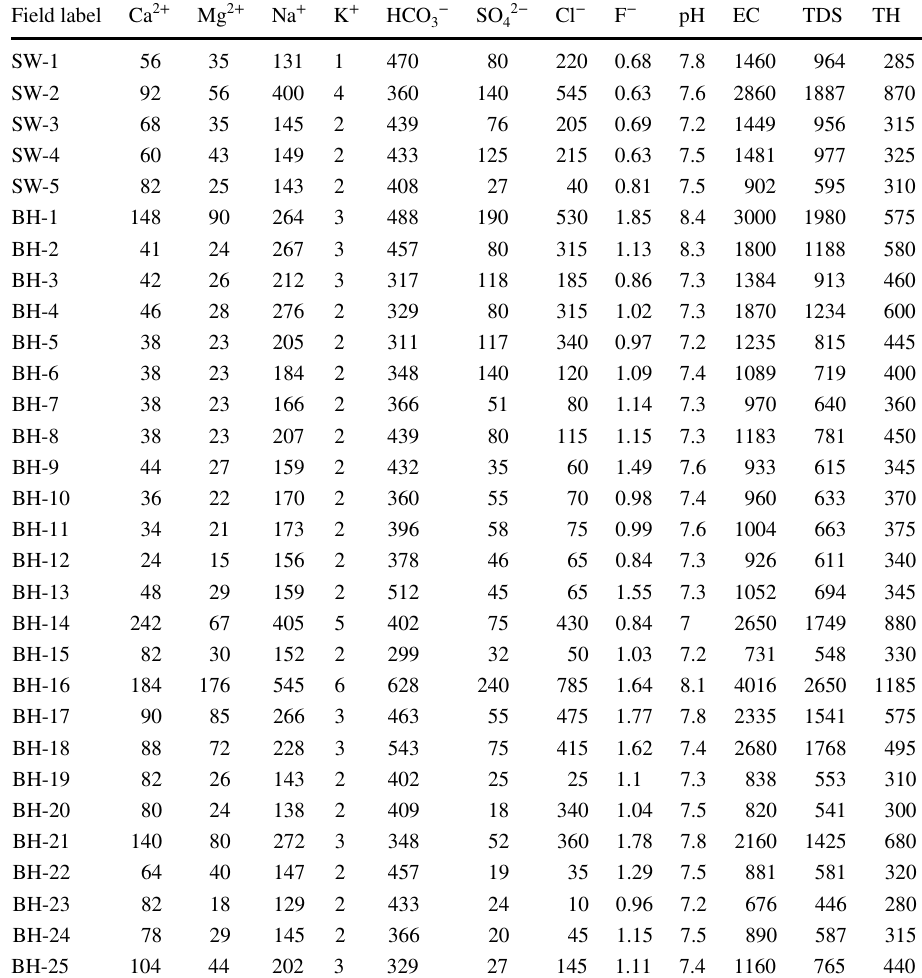
Table 2 Hydrogeochemical characteristics of groundwater (BH) and surface water (SW) of the Mothkur region, Telangana State, South